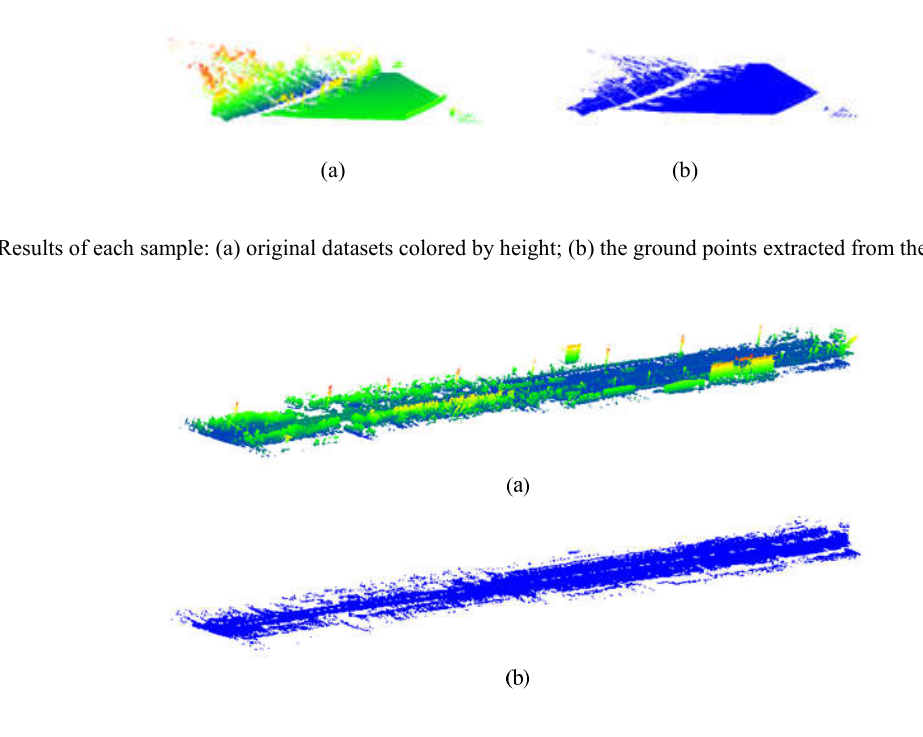
Figure 4.Result of large area dataset: (a) original dataset colored by height; (b) the ground points extracted from the CSF